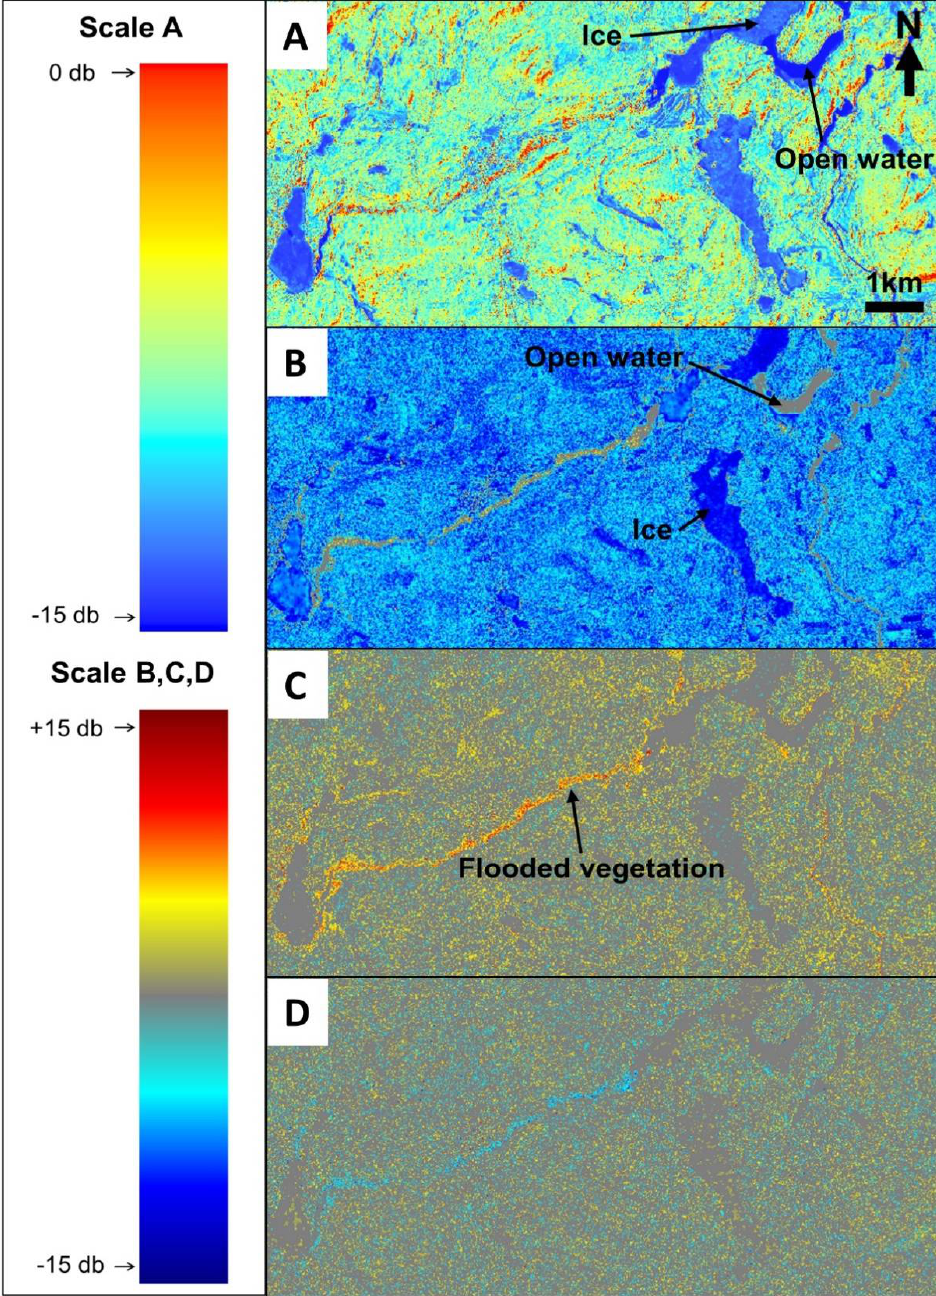
Figure 5. Four Kennaugh elements derived from the dual-pol TerraSAR-X image from 2 April 2016. ( A ) K 0 —the total intensity sum of HH plus VV; ( B ) K 3 —difference double-bounce minus surface scattering; ( C ) K 4 —difference HH minus VV intensity; ( D ) K 7 —phase shift between double-bounce and surface scattering mechanisms. Open water is represented by dark blue in ( A ) and grey in ( B ). Flooded vegetation is represented by grey and yellow in ( B ) and red and yellow in ( C ). Ice cover is represented by light blue in ( A ) and dark blue in ( B ). Inundated vegetation is shown in yellow/red in ( C ) and cyan in ( D ).